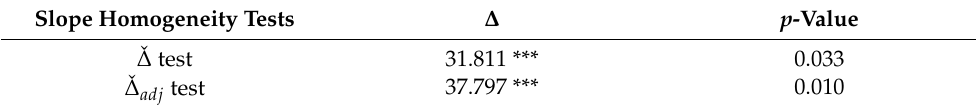
Table 4. Slope homogeneity